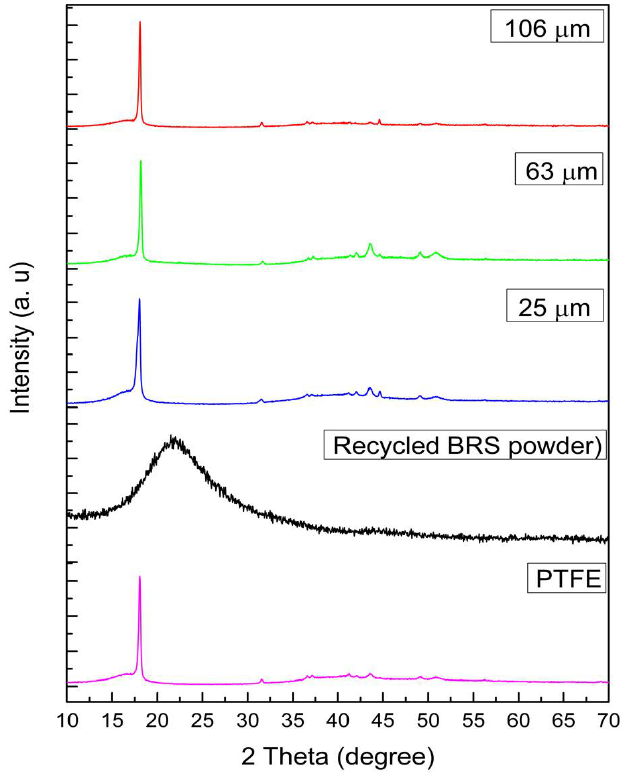
Figure 2. XRD patterns of PTFE, recycled BRS powder and PTFE/recycled BRS